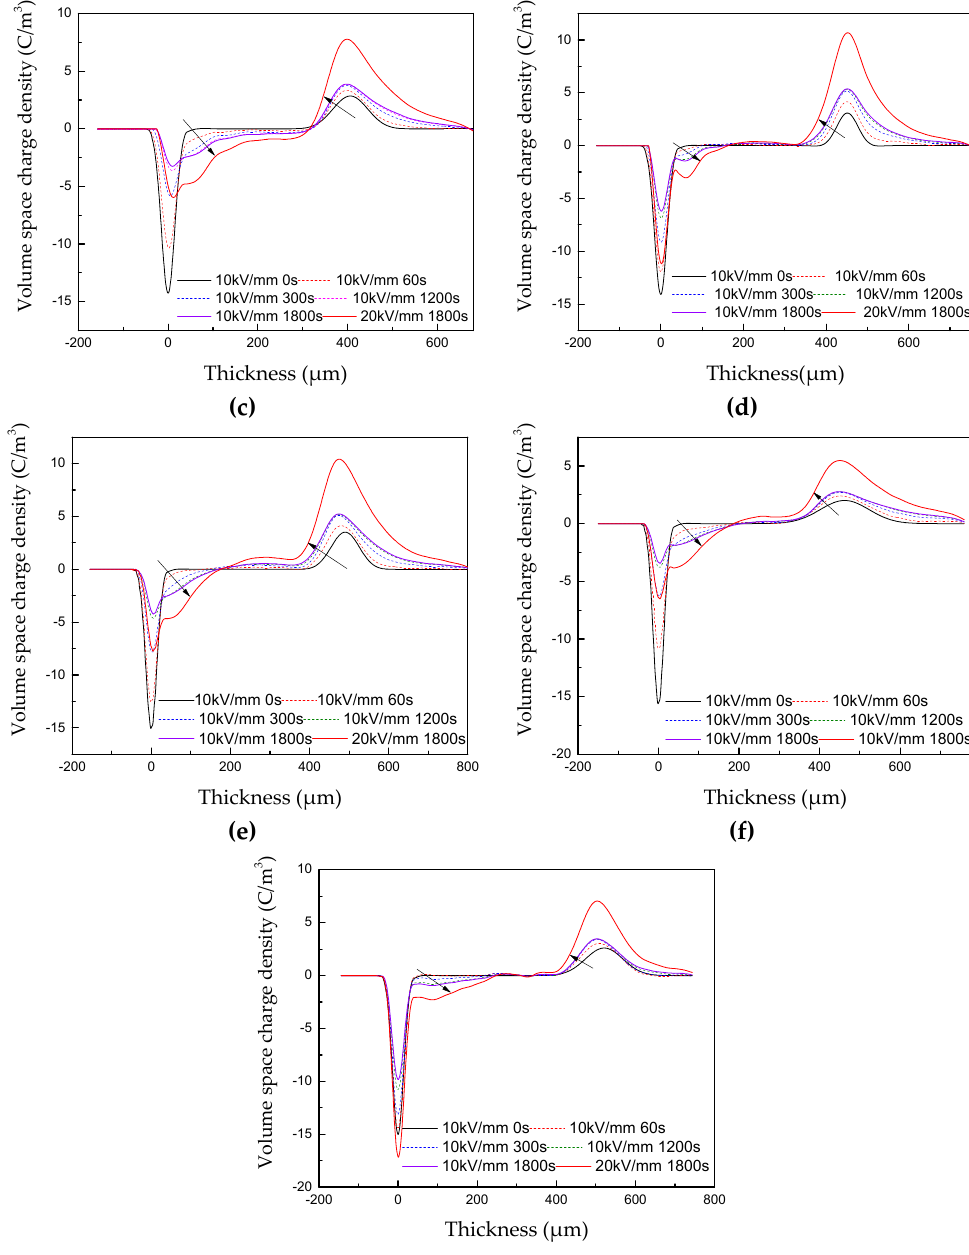
Figure 8. (a),(b),(c),(d),(e),(f) and (g) are respectively the Space charge Characteristics of modified RIP with 0 Figure 8. ( a – g ) are respectively the Space charge Characteristics of modified RIP with 0 wt %, 2.5 wt %, 5 wt %, 10 wt %, 20 wt %, 40 wt % and 50 wt % wt %, 2.5 wt %, 5 wt %, 10 wt %, 20 wt %, 40 wt % and 50 wt % h-BN.